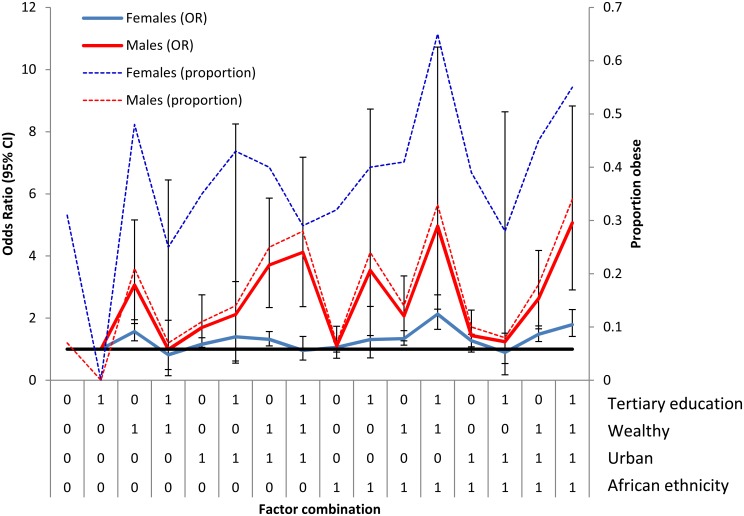
Interactions between significantly identified factors by gender (0 = No, 1 = Yes for each factor) and observed prevalence of obesity (secondary axis).